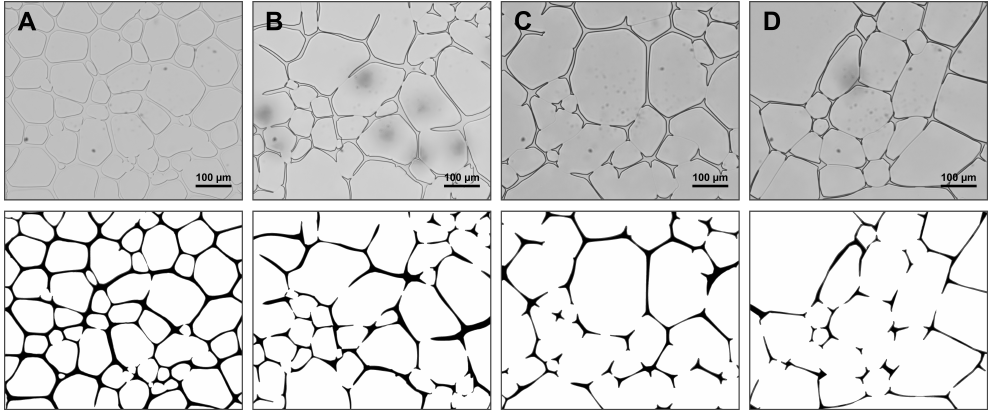
Figure 4. FDM pictures with 50 × magnification of a 10% ( w / w ) sucrose solution after freezing to − 50 °C, subsequent annealing at − 6 °C for different times (( A ) = 60 min, ( B ) = 120 min, ( C ) = 240 min, ( D ) = 360 min) and recooling to − 50 °C ( upper row ). Corresponding labelled pictures show crystalline phase in white and amorphous matrix in black ( lower row ).